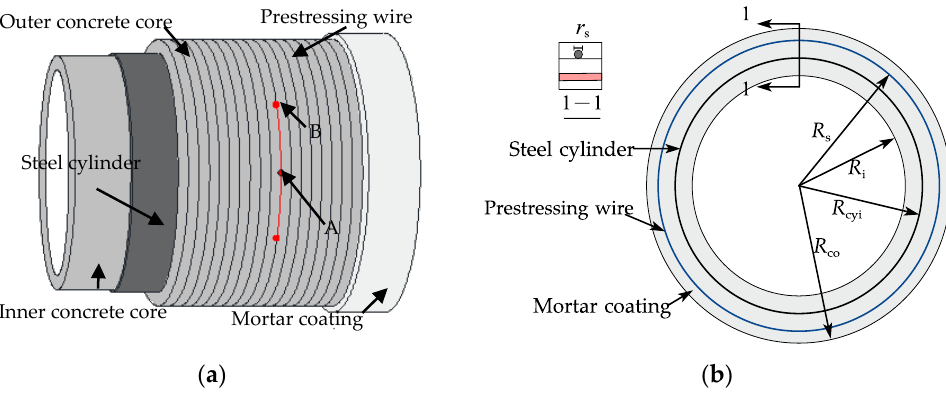
Figure 1. Schematics of ( a ) an ECP with broken wire and ( b ) a cross-section of ECP.